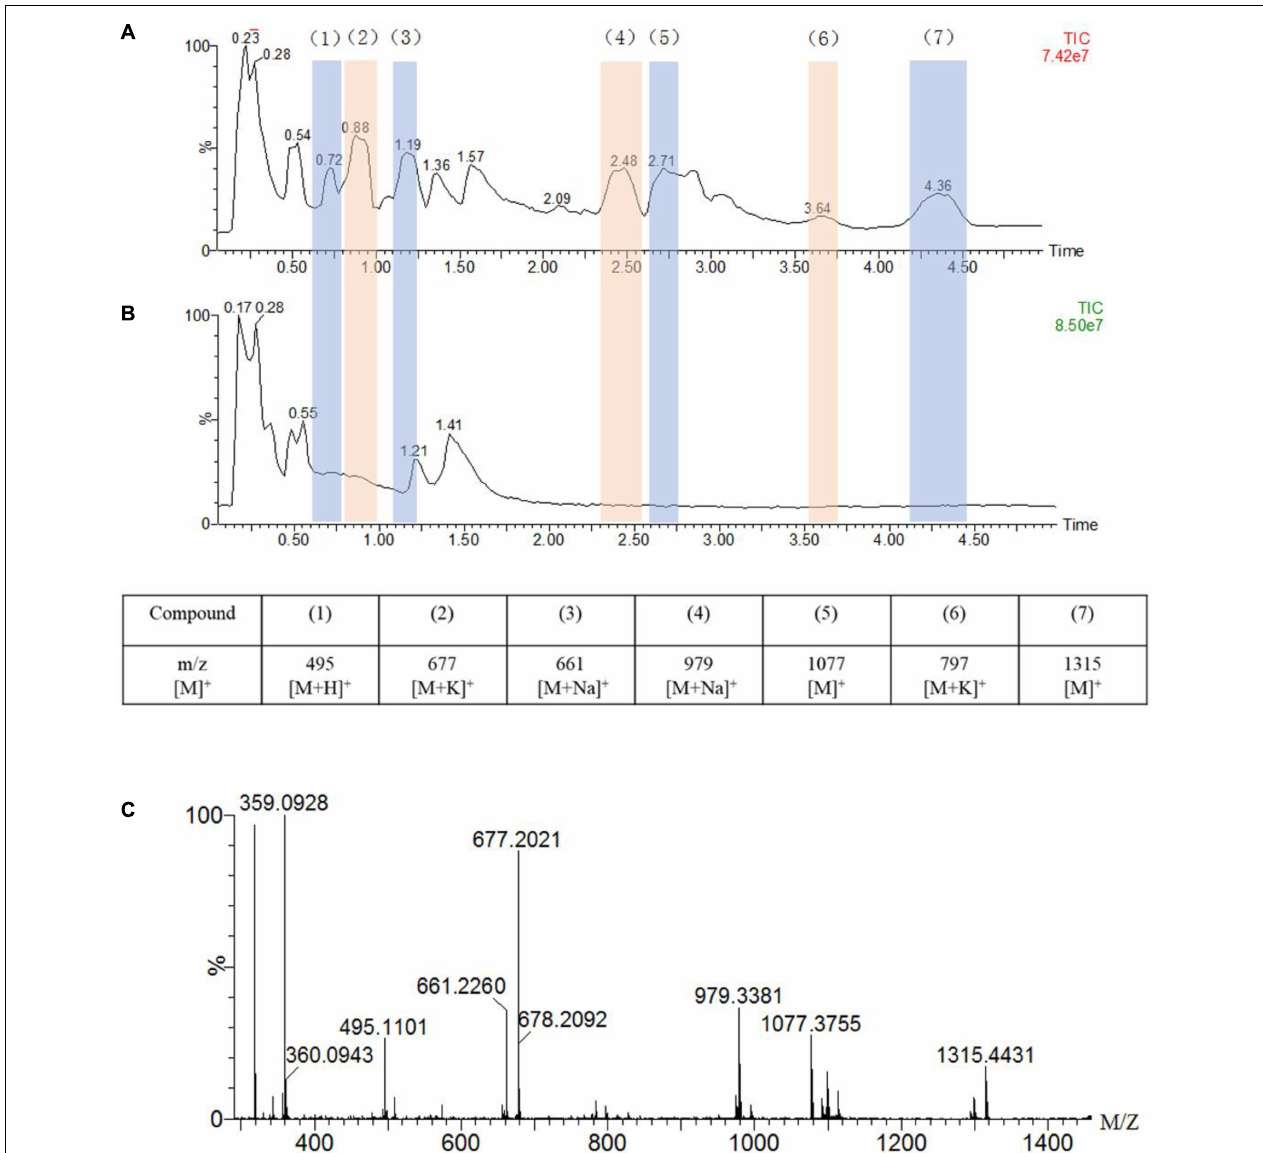
FIGURE 4 | UPLC-MS traces of the oxidation of guaiacylglycerol- β -guaiacyl ether (GGE, 2.5 mM) catalyzed by F43Y/T67R Mb (5 µ M) in the presence of H 2 O 2 (2.0 mM) (A) or in the absence of H 2 O 2 (B) , in potassium phosphate buffer (pH 5.5). Detected products are numbered and listed in the table below the chromatograms together with the corresponding m/z values. (C) Analysis of the oxidation products by ESI–MS spectrometry in a positive